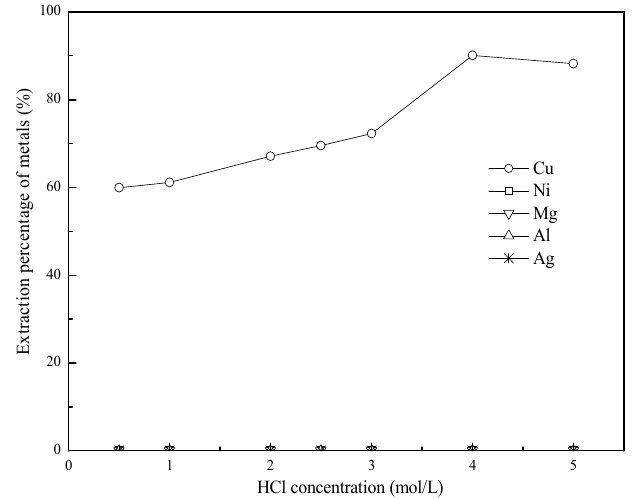
Figure 6. The effect of HCl concentration on the extraction of metal ions with TOPO. To the best of our knowledge, the mechanism of the non-aqueous solvent extraction of Cu with TOPO has not previously been reported, and thus, it was further investigated by using the slope method. The results for Cu extraction for a concentration range of HCl from 2 to 5 mol/L are presented as a plot of logD versus log[H + ] in Figure 7; the slope is 2.177, which indicates the presence of two hydrogen ions in the extracted Cu complex.